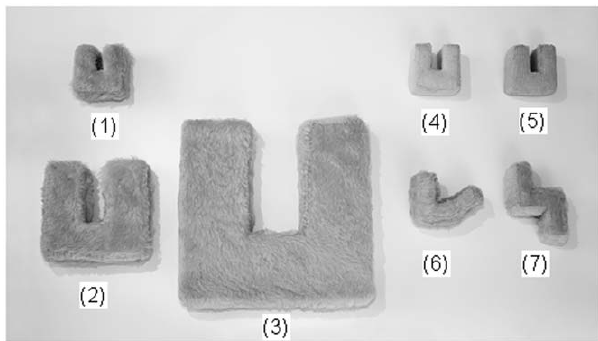
Figure 2. Objects used in experiments 2 and 4. Gable learnt to link the word dax with standard object 1: the DAX object (furry light blue 7.6 cm wide). He was asked to select a DAX from pairs of objects including the DAX, size changes 2 (15.2 cm) and 3 (30.4 cm), texture changes 4 (smooth) and 5 (rough), and shape changes 6 and